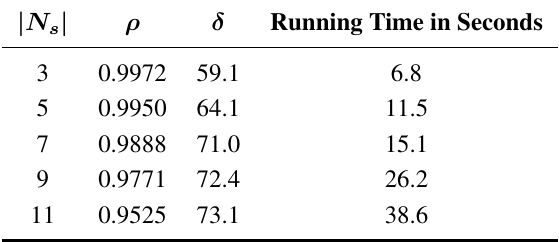
Table 4. Scores of both metrics and running time obtained by the PDADVS model involving | with keeping ξ = 0 . 5 and λ = 1 for Lun.lake _ igm . different values of | N s | N s